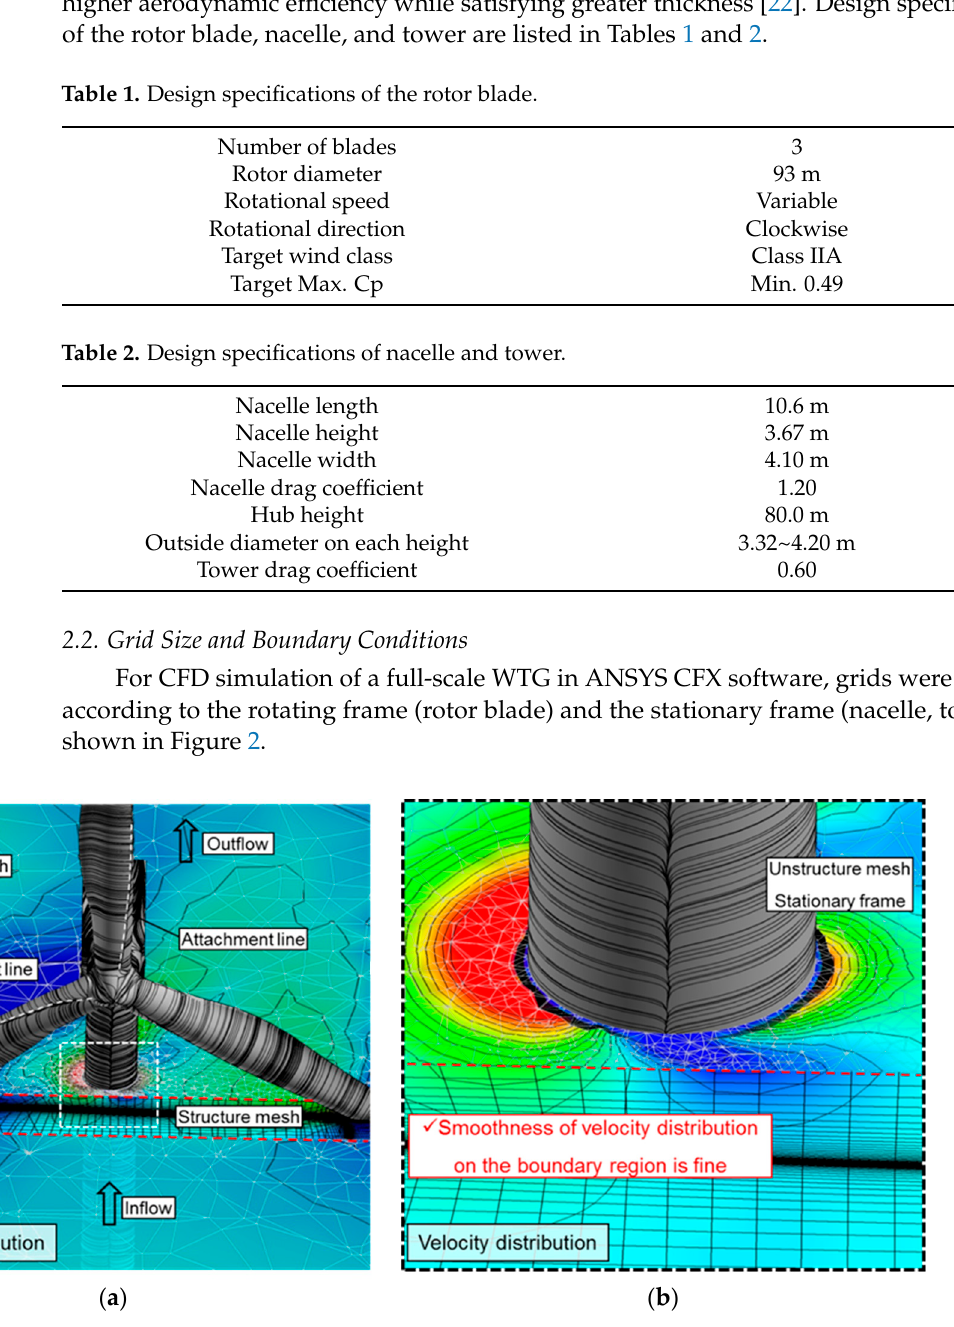
Figure 2. Grids by sliding mesh method and velocity distribution. ( a ) Overall view, ( b ) enlarged view on the boundary region.